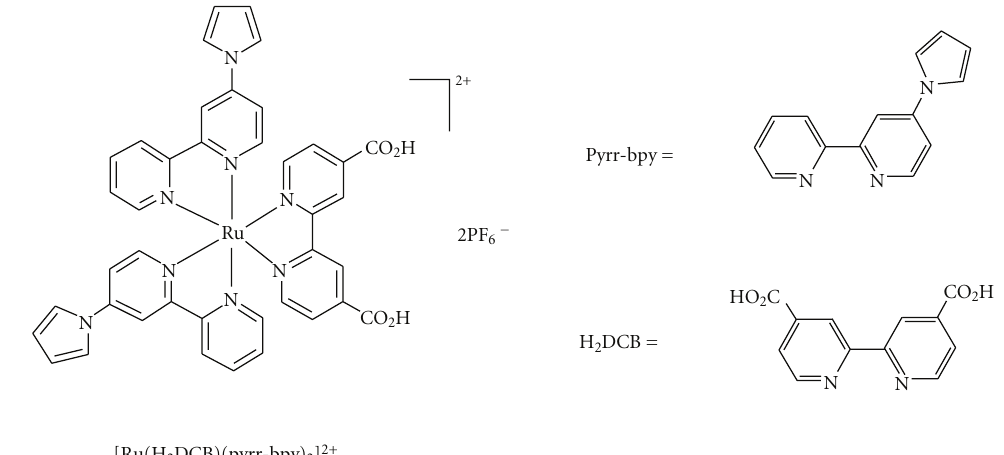
Figure 18: Ru(II) complex uses for in situ photoassisted PEDOP growth.